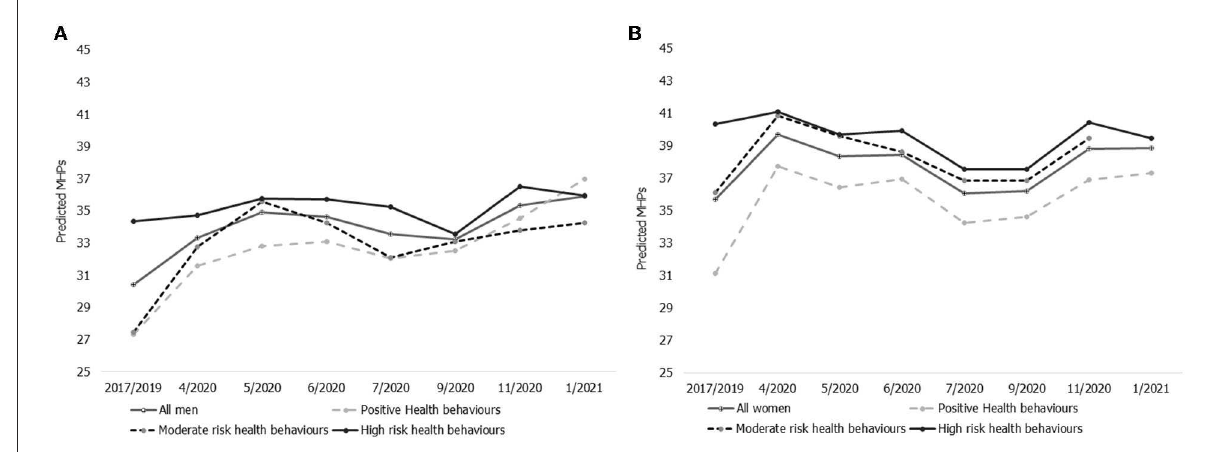
FIGURE5 (A) Changes in MHPs during the COVID-19 pandemic by health behavior clusters among men. MHPs (scale 0–100) during the first year of the COVID-19 pandemic (4/2020–01/2021) in the UK. Relative to pre-pandemic measures 2017/2019 (fixed effects regression of the same person, adjusted for general changes in age, age-squared and weighted with each person’s last individual weight). (B) Changes in MHPs during the COVID-19 pandemic by health behavior clusters among women. MHPs (scale 0–100) during the first year of the COVID-19 pandemic (4/2020–01/2021) in the UK. Relative to pre-pandemic measures 2017/2019 (fixed effects regression of the same person, adjusted for general changes in age, age-squared and weighted with each person’s last individual